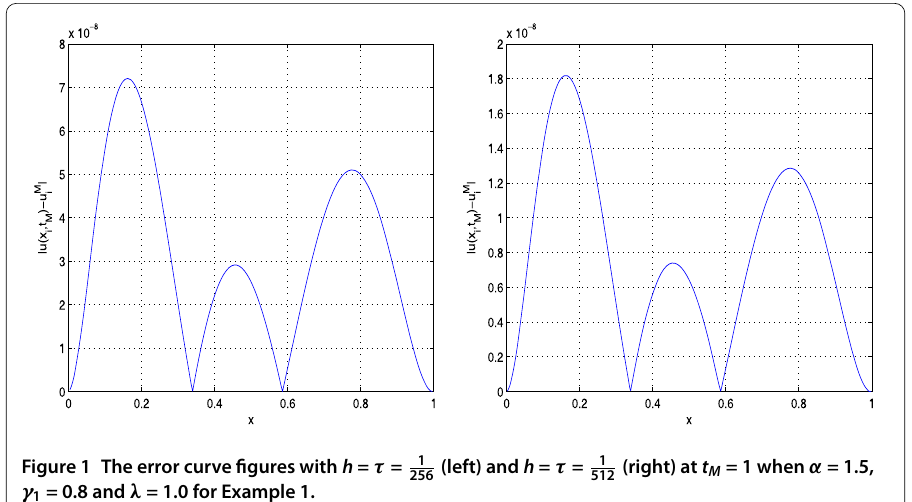
Figure 1 The error curve figures with h = τ = 1 γ 1 = 0.8 and λ = 1.0 for Example 1.